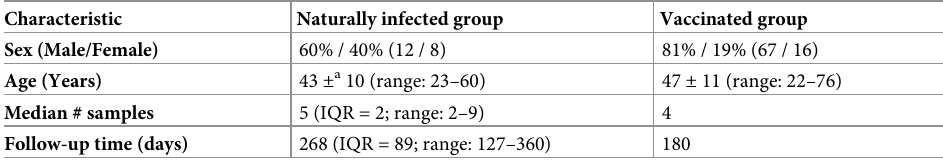
Table 1. Patient